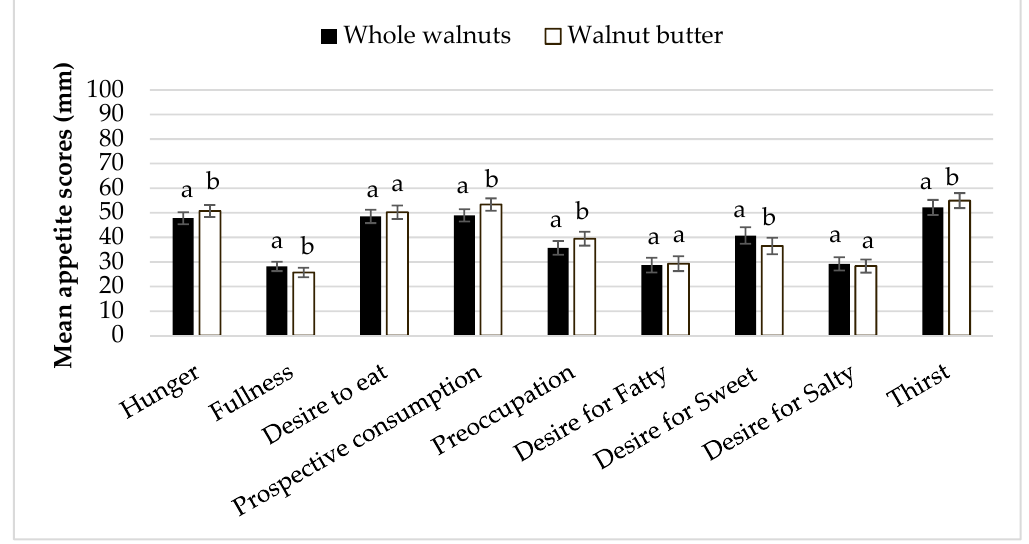
Figure 6. Mean ± S.E.M appetite indices subsequent walnut consumption. Letters that are different denote significant differences between nut form ( p < 0.05).